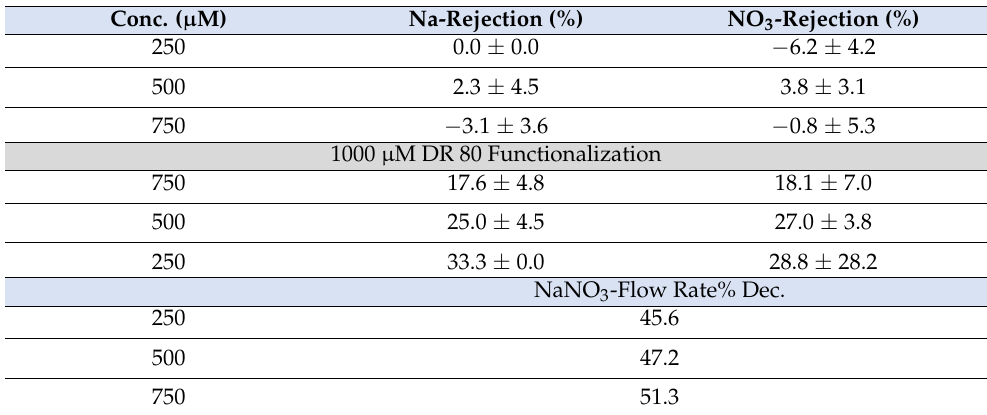
Table 3. Rejection and flow rate values for 250, 500, and 750 µ M concentrations of sodium nitrate solution pre- and post-azo-dye-functionalization, on an unmodified polycarbonate filter, with direct red 80 at 1000 µ M for 40